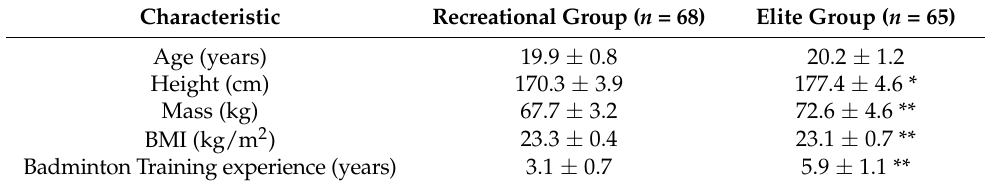
Table 1. Basic demographic characteristics of the